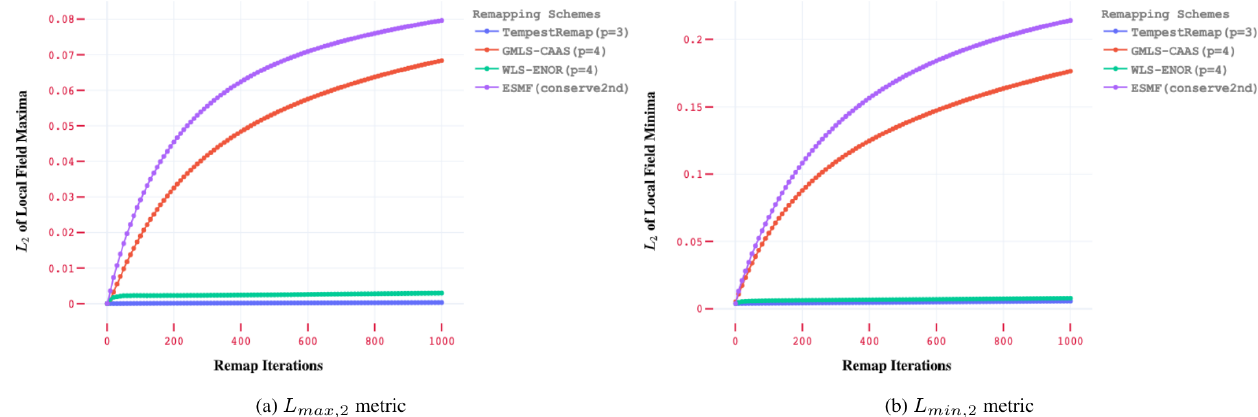
Figure 14. L max , 2 (a) and L min , 2 (b) metric evolution for the TOPO field on the CS(r2)–MPAS(r2)